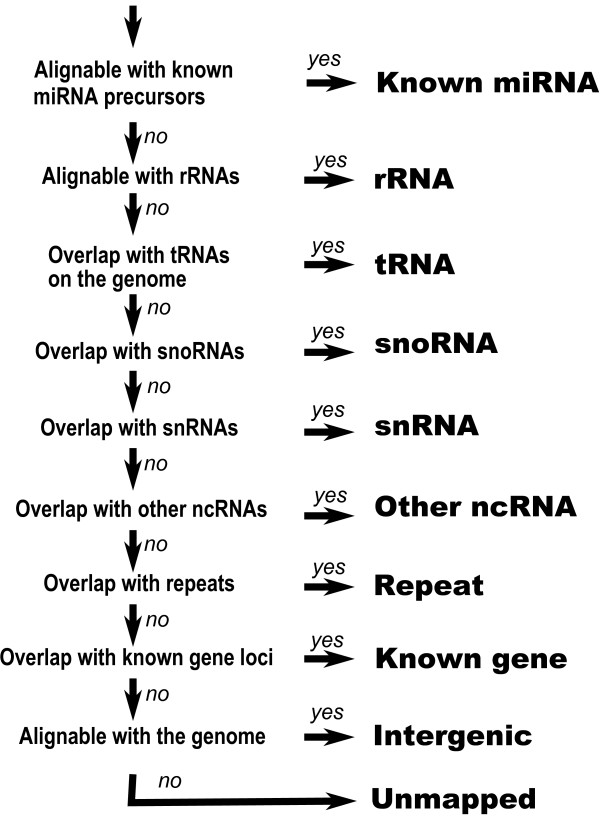
Classification flow of small RNAs. Some sequences are alignable with several classes of RNAs and multiple loci on the genome. We assign one sequence to one class based on this flow.